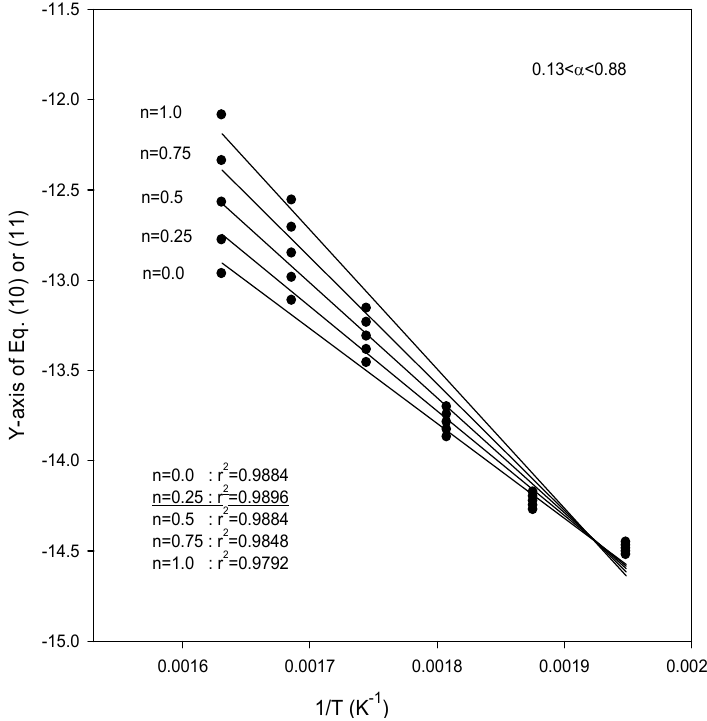
Figure 4. Plots of Equations (10) or (11) for the application of the kinetic analysis method at a heating rate of 3.1 °C/min for SCE.